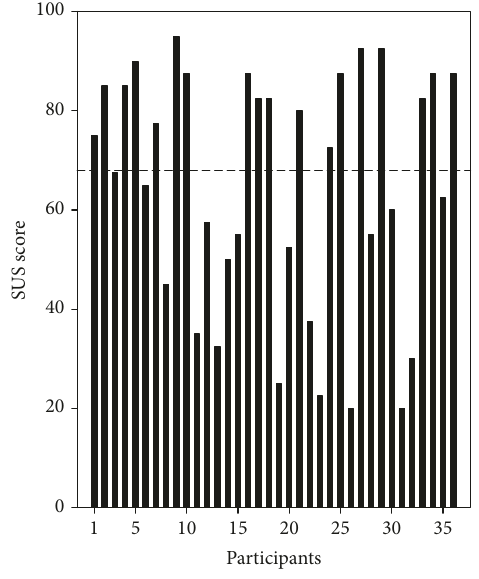
Figure 12: Fibaro SUS